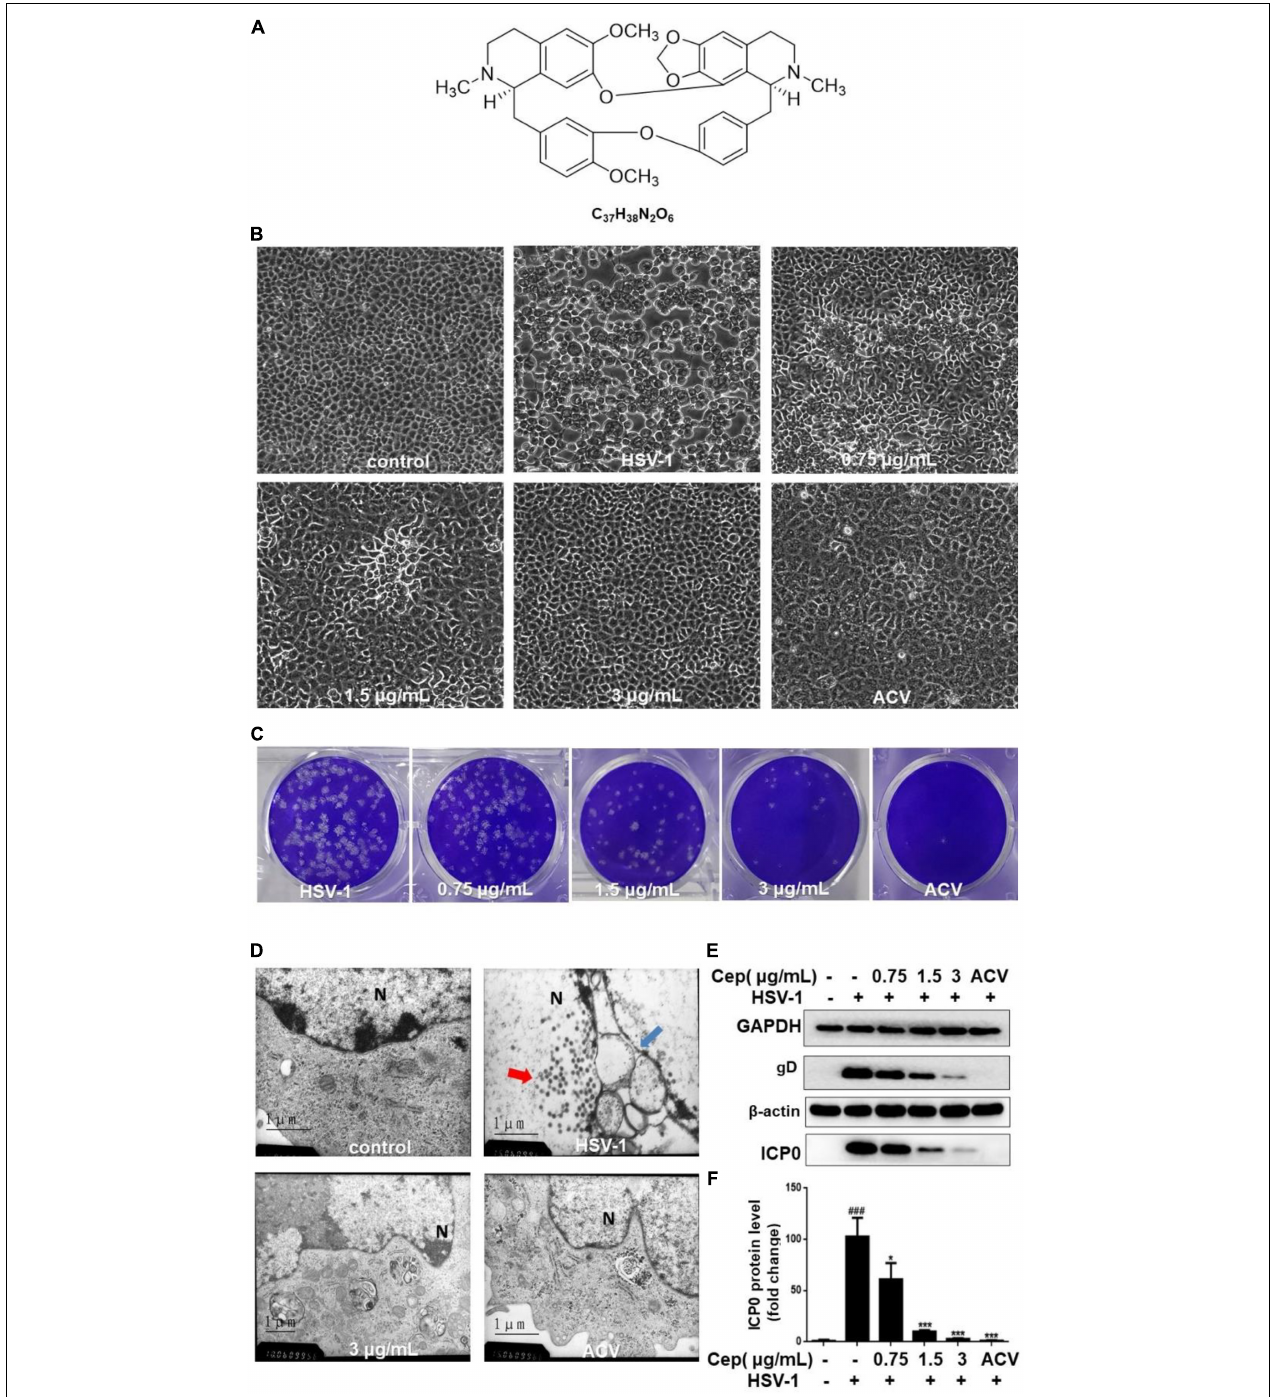
FIGURE 1 | CEP inhibited HSV-1 replication in vitro . (A) The chemical structure of CEP. (B) Vero cells were inoculated with HSV-1 (MOI = 1) and treated with different concentrations of CEP for 36 h, and ACV was used as a positive control. The cytopathic condition of cells was photographed by light microscopy (200 × ). (C) Vero cells were inoculated with HSV-1 (MOI = 1.5) and treated with different concentrations of CEP for 72 h. Plaque experiments were performed to detect the inhibitory effect. (D) Vero cells processing HSV-1 (MOI = 1) infection were treated with CEP (3 µ g/mL) for 36 h. The transmission electron microscope was adopted to examine the virus particles and cell structure. Red arrows, viruses in the nucleus; blue arrows, disrupted nuclear envelope; N, Nucleus. (E) Vero cells in six-well plates were infected with HSV-1 (MOI = 1) in the presence of the CEP at different concentrations, including 0.75, 1.5, and 3 µ g/mL for 36 h. Cell lysates were collected for Western blotting as indicated. (F) Results from three independent experiments were quantitated and presented as means ± SD. ### P < 0.001 indicates significant difference vs. NC group; * P < 0.05; *** P < 0.001 indicates significant difference vs. model group.